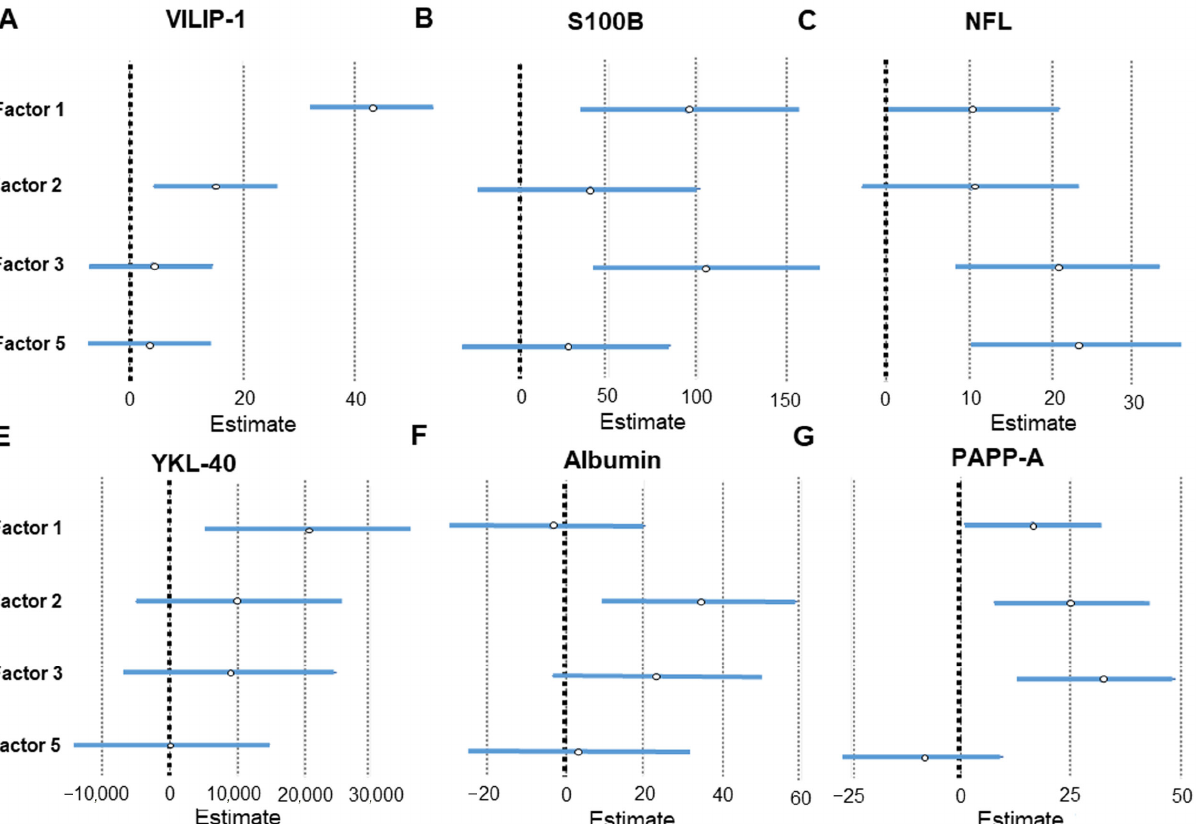
Figure 6. Association of CSF AD biomarkers – VILIP-1 ( A ), S100B ( B ), NFL ( C ), YKL-40 ( E ), albumin ( F ), and PAPP-A ( G ) with CSF macro- and microelement groups revealed by PCA. Effect sizes and 95% confidence intervals are given by linear regression analysis (statistically significant factors are considered those represented with horizontal lines that do not intersect with the vertical line at 0). Factor 1; CSF As, Ba, Ca, Co, Cu, Fe, K, Mg, Mn, Na, Ni, S, Se, Sr, Tl, and Zn; Factor 2; CSF Al, Cd, and Pb; Factor 3; CSF B and Li; Factor 5; CSF Hg and